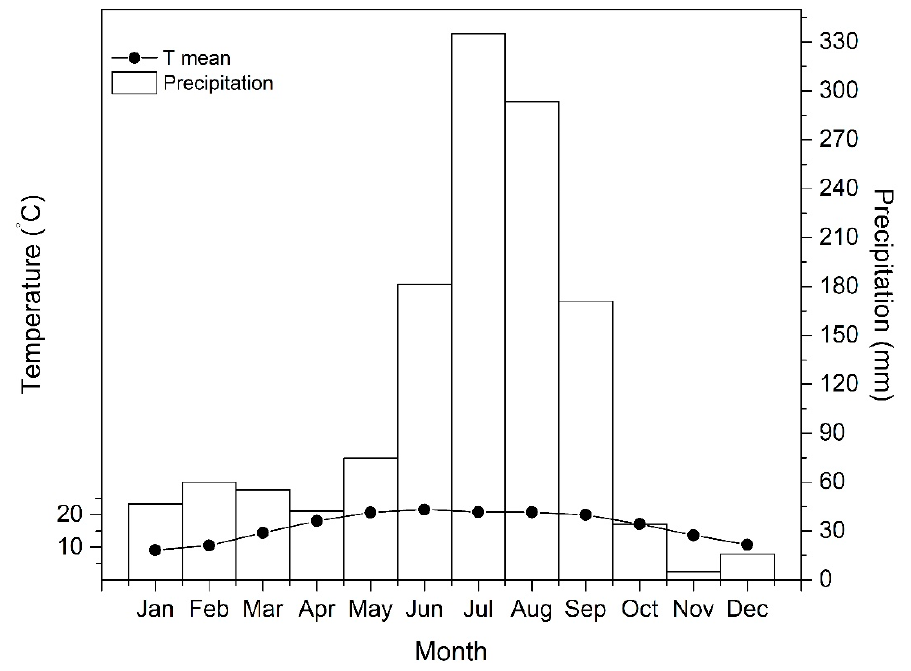
Figure 2. Climate diagram showing monthly mean temperature (1978–2016) and precipitation (1972–2016) records in Dadeldhura, western Nepal.